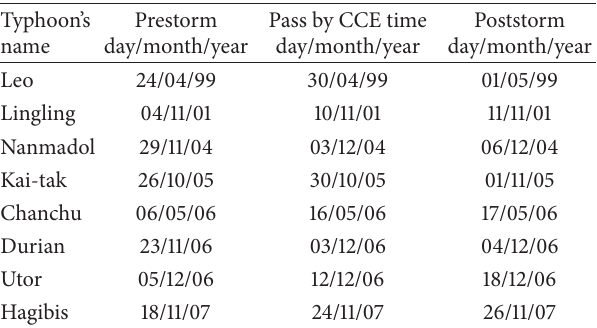
Table 3: The prestorm and poststorm dates corresponding to Figure 11 for SST